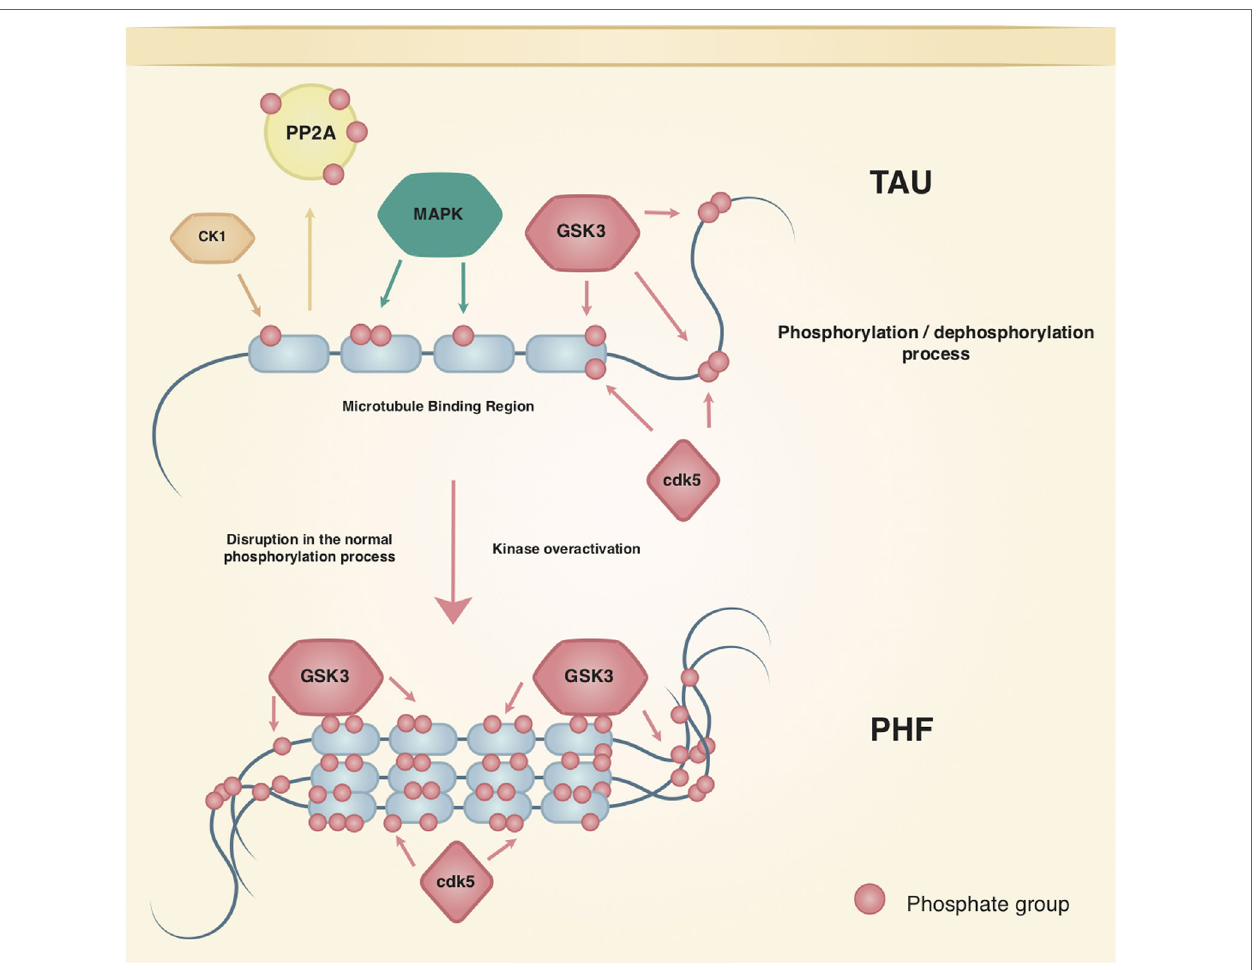
FiGURe 1 | Regulation of tau phosphorylation. Tau is a native phosphoprotein that relies on an equilibrium of phosphorylation and dephosphorylation to perform physiological and neuroplasticity processes. Tau most studied kinases and phosphatase are shown; kinases such as cdk5 and GSK3 have been related to the hallmark lesions in Alzheimer’s